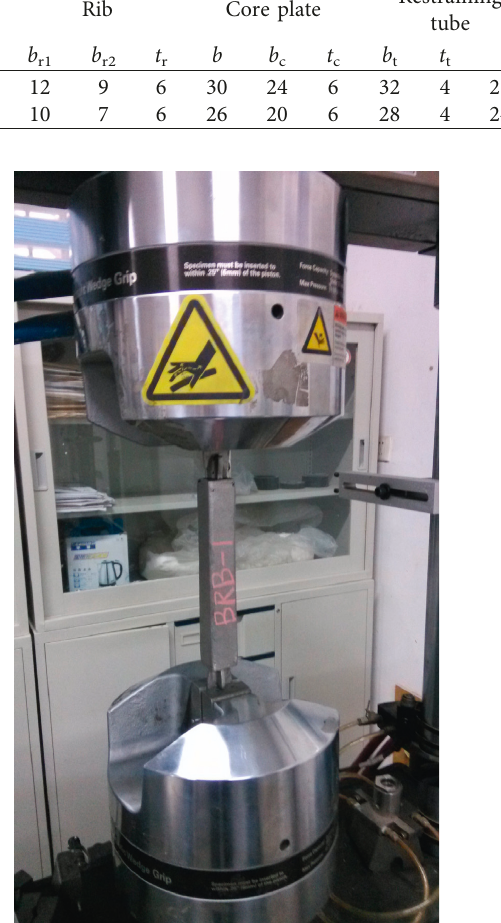
Figure 7: Loading of the